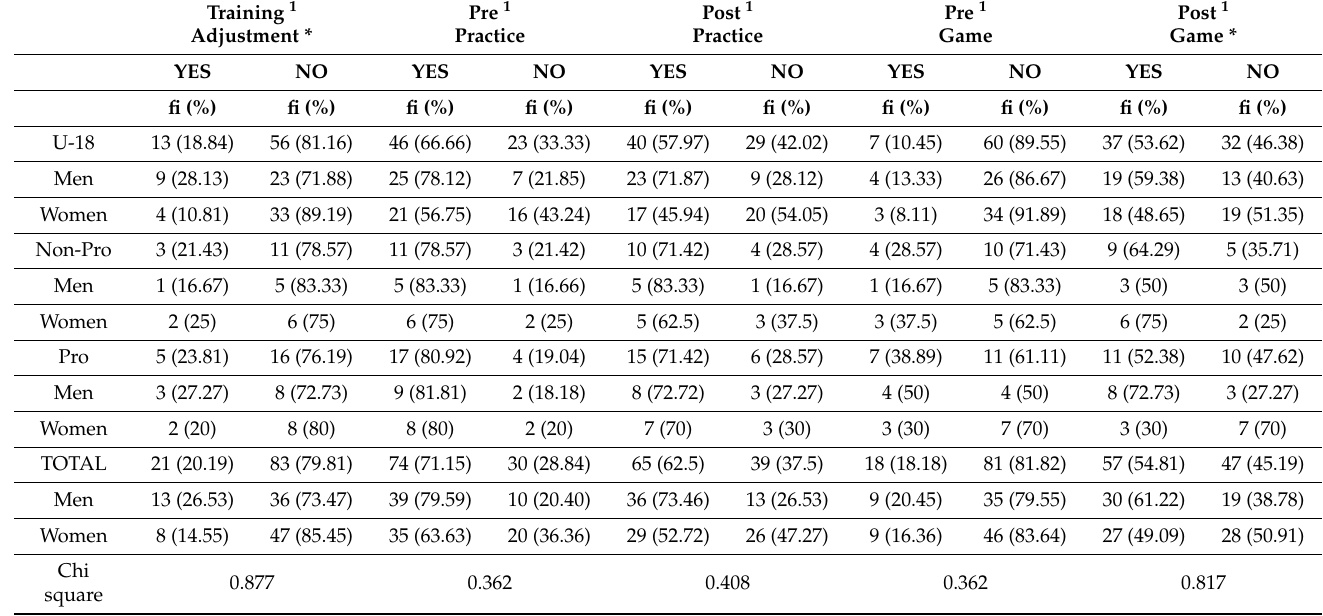
Figure 2. Sports nutrition knowledge (total). Table 3. Sports nutrition practices by category, gender and thematic